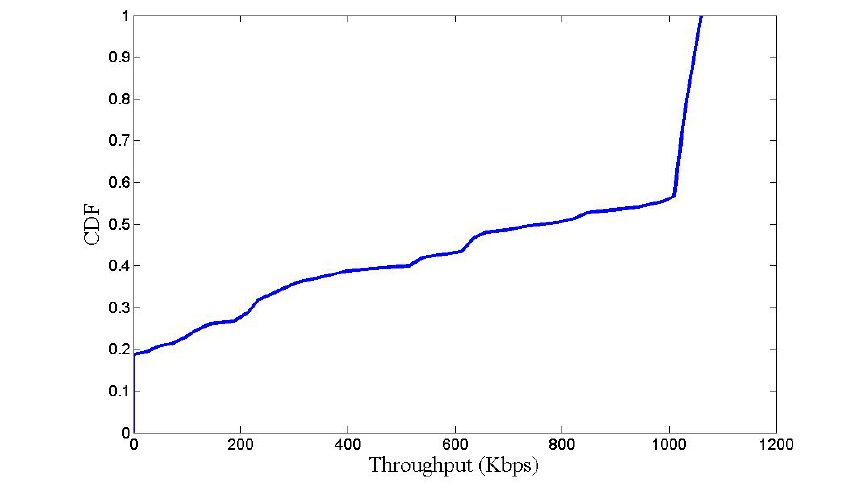
Figure 1. Throughput measurement result of multi-hop UAV network.